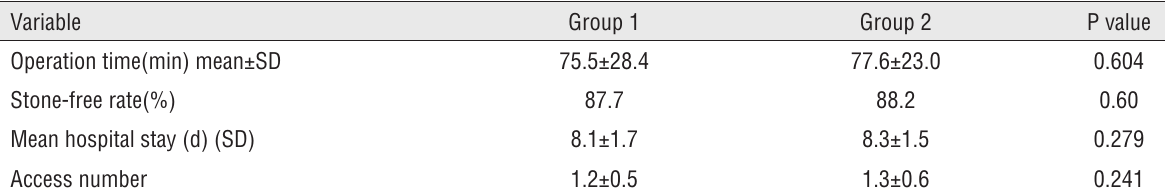
Table 2 - Operative details and outcomes in the two groups.